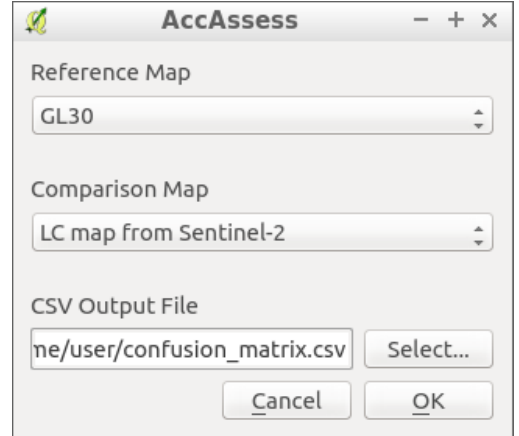
Figure 2. Interface of the QGIS Accuracy Assessment